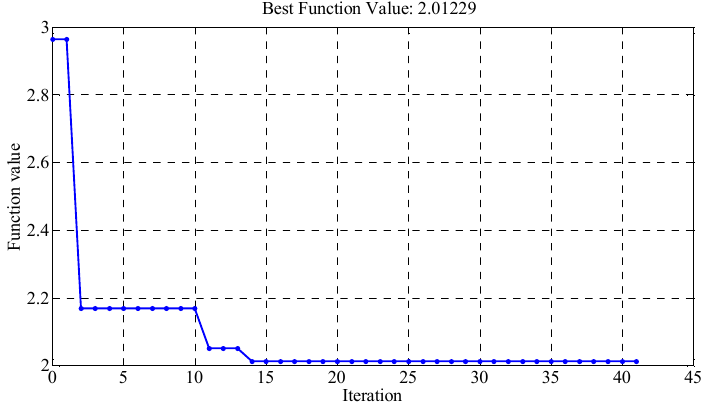
Figure 8. The calculation process of simulated annealing (SA) algorithm method.